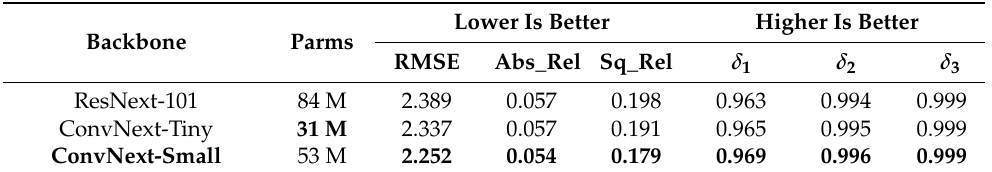
Table 8. KITTI Eigen split evaluation result, with different backbone networks (except for the backbone network, other environments are the same). Lower Is Better Higher Is Better Backbone Parms RMSE Abs_Rel Sq_Rel δ 1